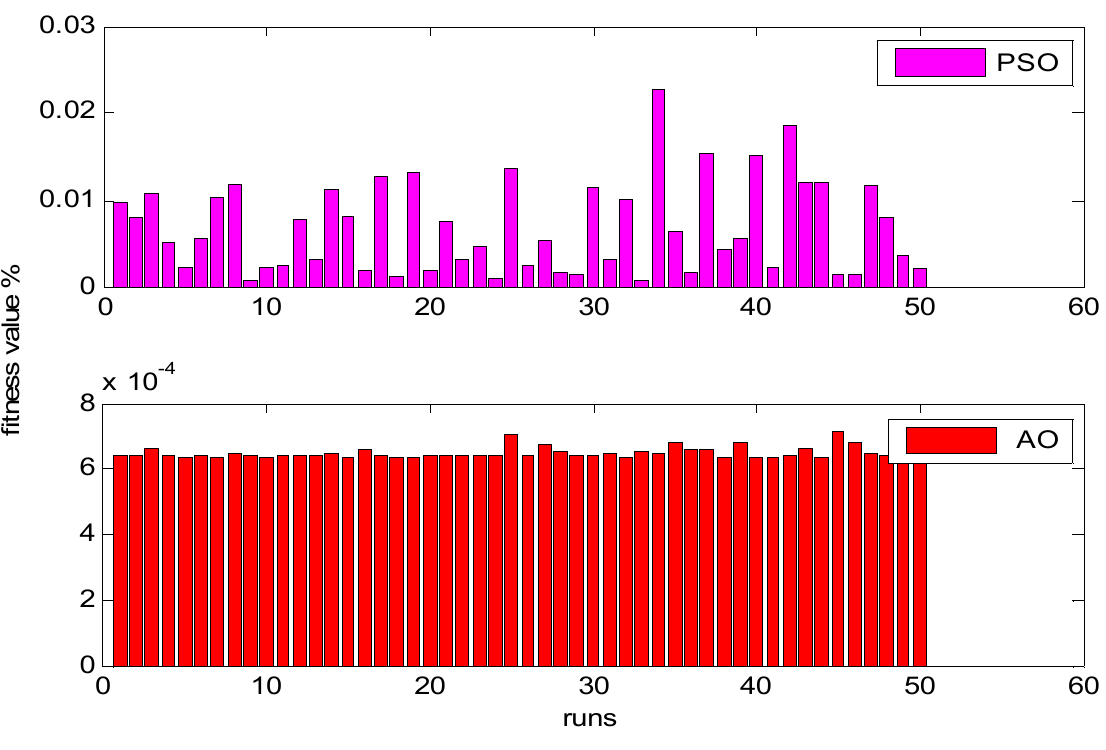
Figure 4. Bar chart of each run for Zafarana site.